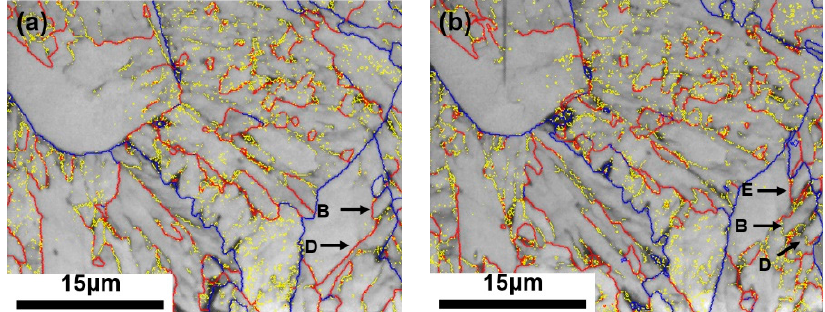
Figure 5. GB orientation of primary Widmanstätten sideplates cutting process. ( a ) 119th layer, ( b ) 127th layer.